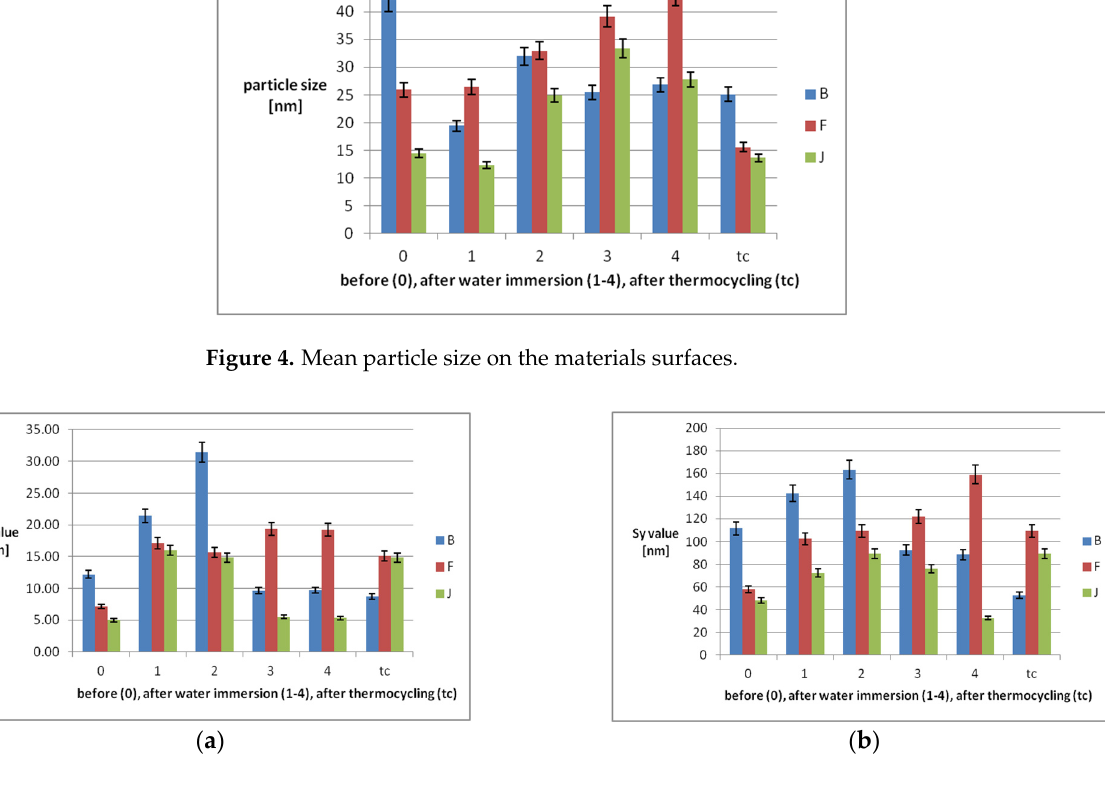
Figure 4. Mean particle size on the materials surfaces.